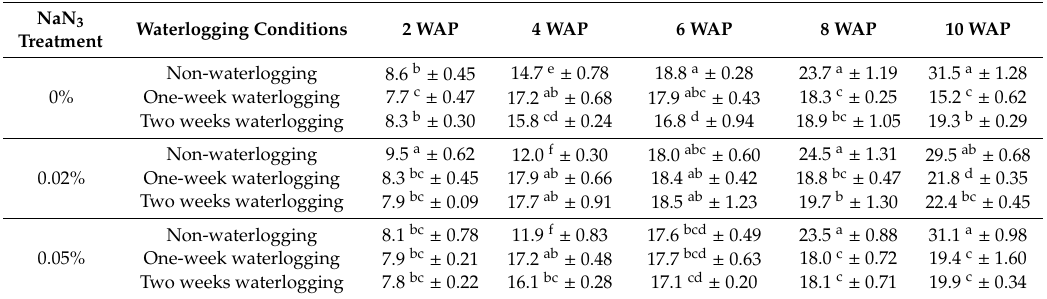
Table 1. Height (cm) of okra plants grown from NaN 3 -treated seeds subjected to different waterlogging conditions four weeks after planting (WAP).